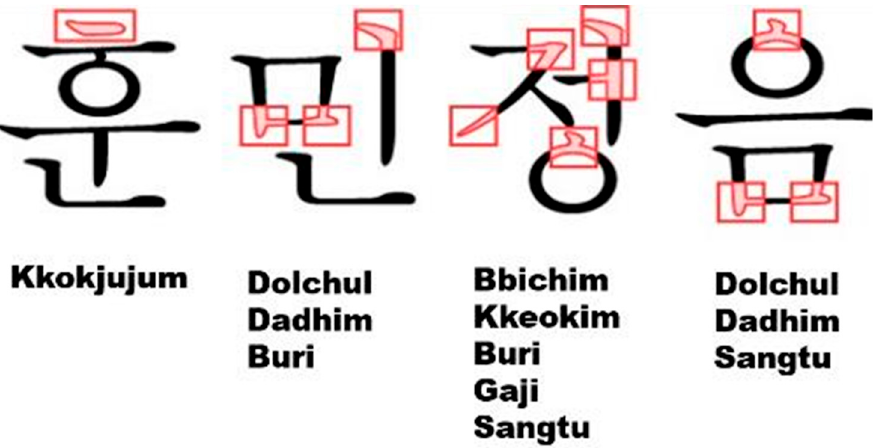
Figure 6. Target Letter for stroke element object detection. In the figure, the stroke elements of each Hangul letter are shown in red, and you can see the stroke elements that can be found in each letter. The above stroke elements are used to detect stroke elements. Table 3. Structured (A), semi-structured (B), and unstructured (C) font groups according to font classification criteria.